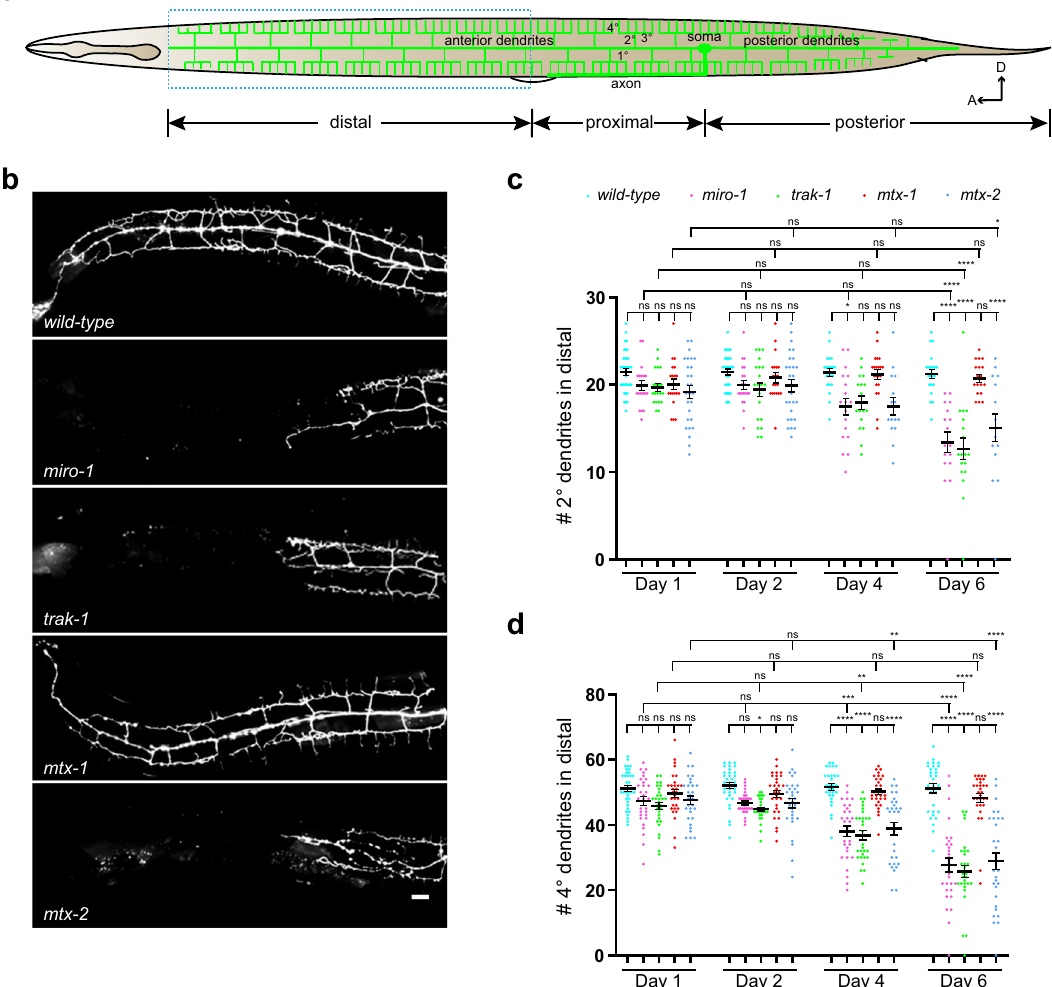
Fig. 6 Impairment of mitochondrial traf fi cking leads to dendrite degeneration. a A schematic diagram showing the distal, proximal, and posterior dendrites of PVD. Anterior is to the left and dorsal is up. b Confocal images of PVD > GFP in wild type, miro-1, trak-1, mtx-1 , and mtx-2 mutants at Day 6. Scale bar: 10 μ m. c , d Quanti fi cation of the number of 2 o and 4 o in the distal dendrite in wild type, miro-1, trak-1, mtx-1 , and mtx-2 mutants at Day 1, 2, 4,